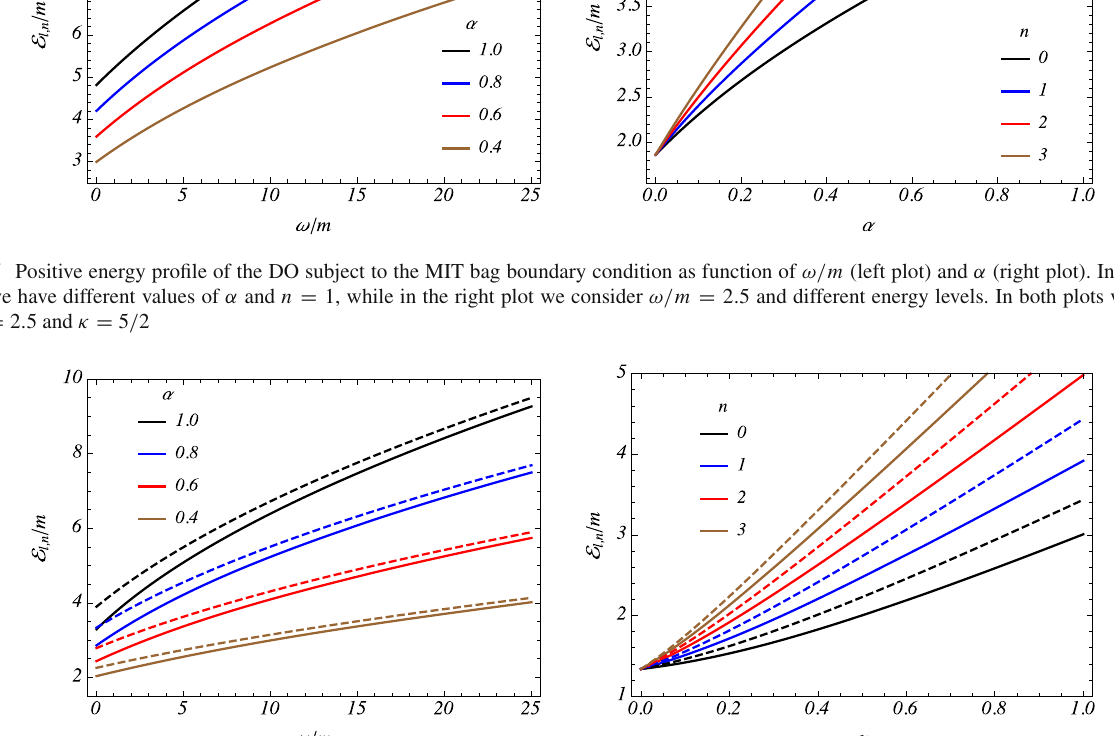
In both plots we have mr 0 = 2 . 5, l = 1 and ξ = 0. The full and dashed curves represents the Dirichlet and Neumann boundary condi- tions,